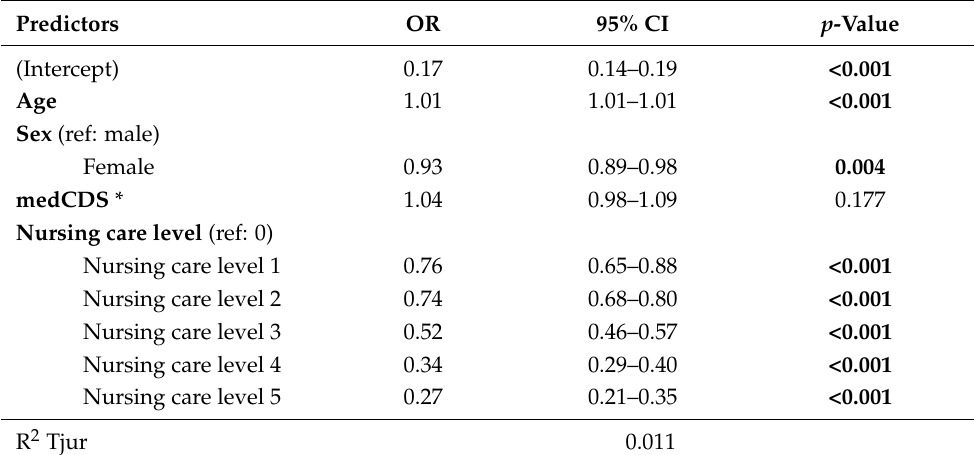
Figure 1. Distribution of patients, GPs, and practices in the defined populations (AP: active popula- tion, IP: inactive population, NEP: non-enrolled potentials). Table 1. Group comparison of AP and NEP